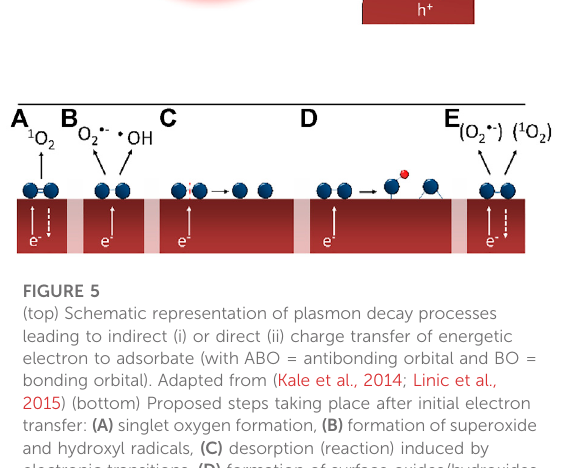
(Figure 4B) as the absorption band at 435 nm of the cis isomer